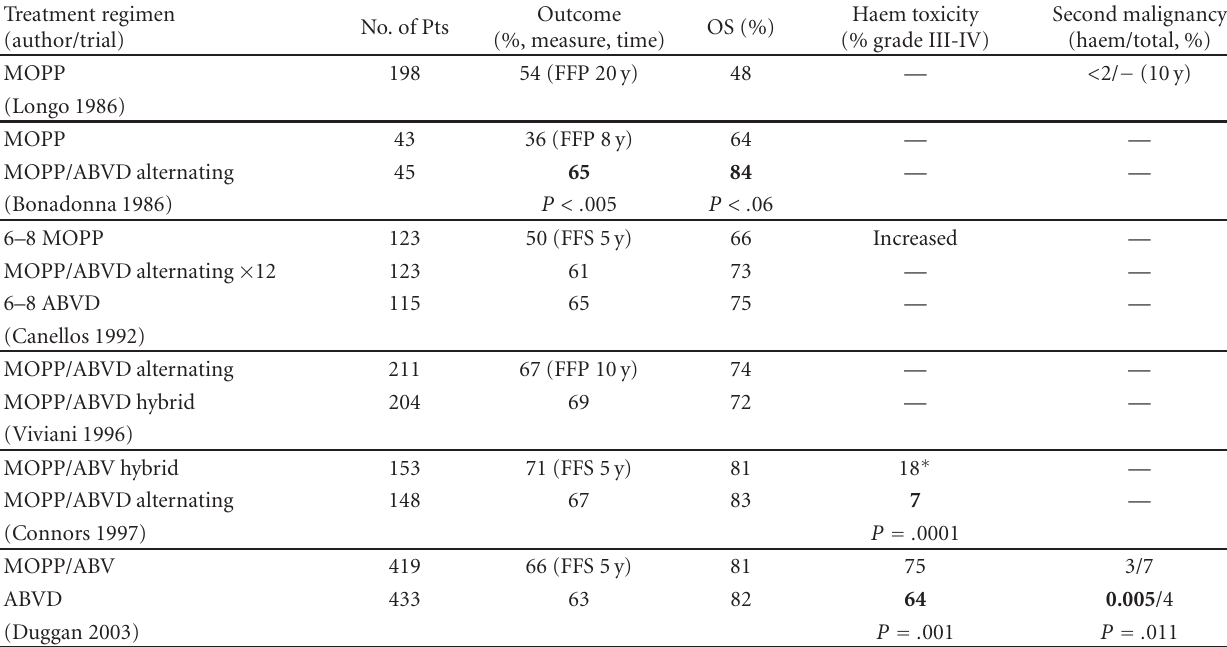
Table 5: Trials comparing MOPP- and ABVD-based regimens for the treatment of advanced stage Hodgkin disease. Numbers in bold are statistically significant with P values where significant. ∗ Febrile neutropenia. Abbreviations: OS: overall survival; MOPP: mechlorethamine, vincristine, procarbazine, prednisolone; ABVD: doxorubicin, bleomycin, vinblastine, and dacarbazine; MOPP/ABV: mechlorethamine, vincristine, procarbazine, prednisolone, doxorubicin, bleomycin, and